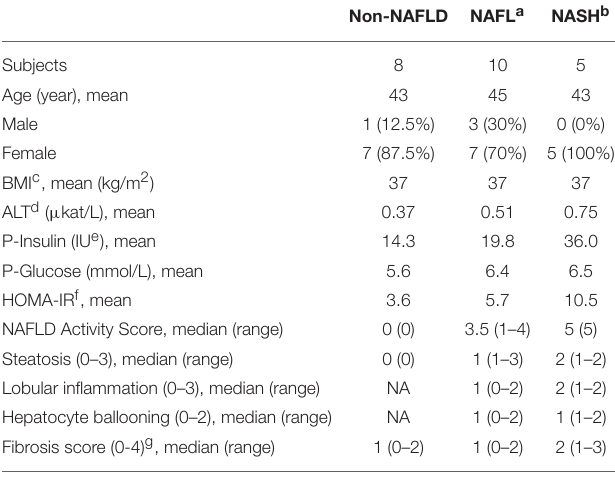
TABLE 2 | Bariatric surgery cohort